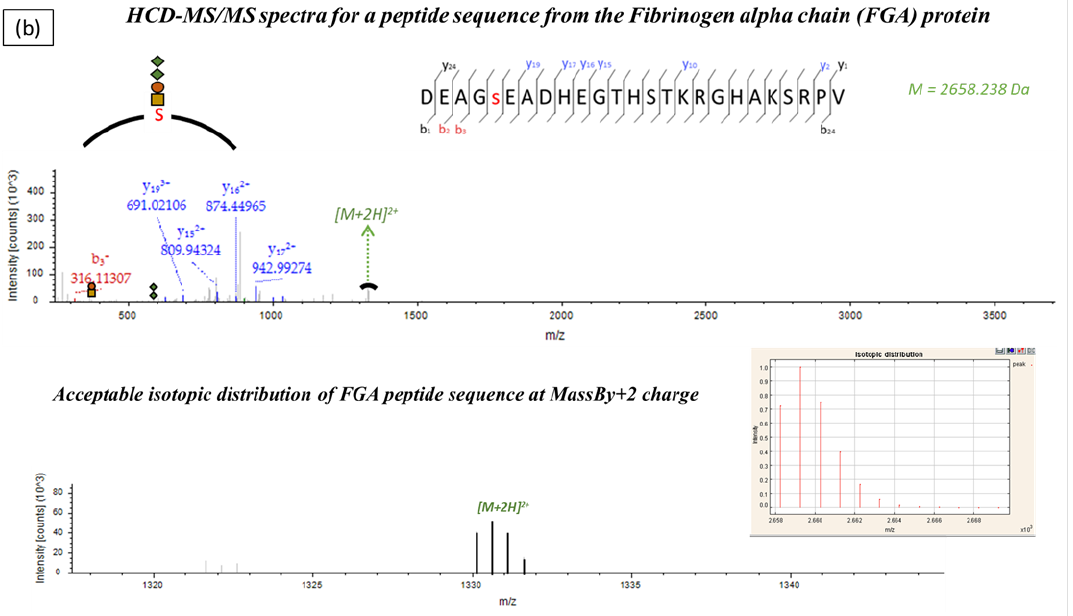
Figure 2. Quality check of HCD-MS/MS fragment spectra of the identified glycopeptides. Spectra as observed in Proteome Discoverer 1.4 are depicted along with their matched isotopic distributions of theoretical (insert) and experimental glycopeptide peaks. ( a ) Insulin-like growth factor II (IGF2) at a charge of +1 and ( b ) Fibrinogen alpha chain (FGA) at a charge of (+2).